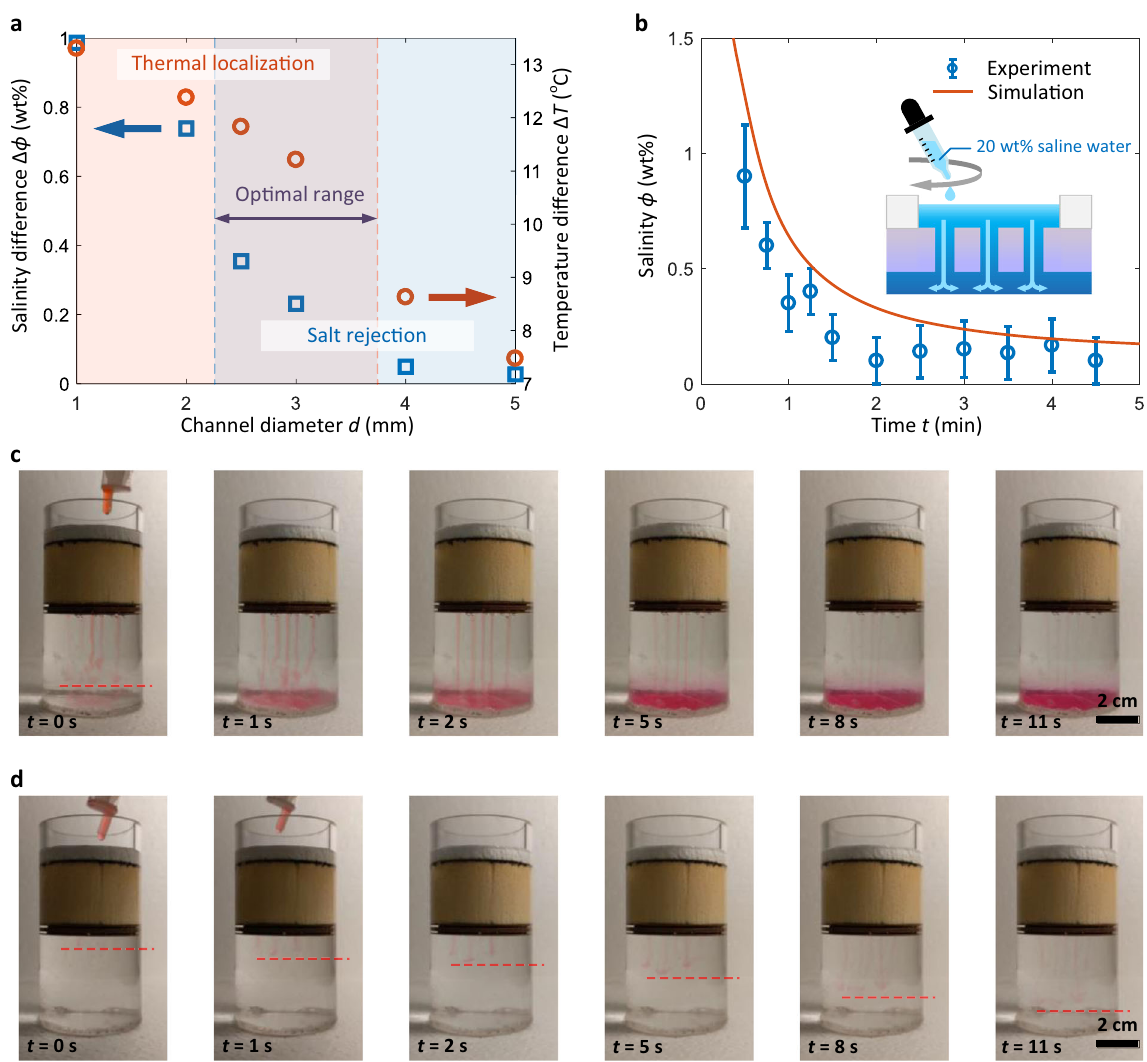
Fig. 3 Fluidic fl ow engineered in the con fi ned water layer. a Salinity ( Δ ϕ ) and temperature ( Δ T ) difference across the macrochannel as a function of the macrochannel diameter d . The sharp transition of Δ ϕ and Δ T (marked by the blue and red dashed lines, respectively) indicates the convection-dominated regime. The overlap of thermal localization (light red regime) and salt rejection (blue regime) represents the optimal design for the macrochannel diameter. b Con fi ned water layer salinity ϕ as a function of time t after dripping 2.3 mL 20 wt% brine in an isothermal condition. ϕ was measured by a digital refractometer. Error bars represent the combination of instrumental uncertainty of digital refractometer (0.1 wt%) and the standard deviation of three-time measurements. Good agreement between the experiment and model prediction (red curve) is shown. c Time-lapse image of the transport of 20 wt% brine visualized by food dye. d Time-lapse image of the transport of DI water visualized by food dye. For both visualization tests, the reservoir initially contained DI water only. The faster transport of 20 wt% brine ( c ) than DI water ( d ) con fi rmed the existence of the natural convection